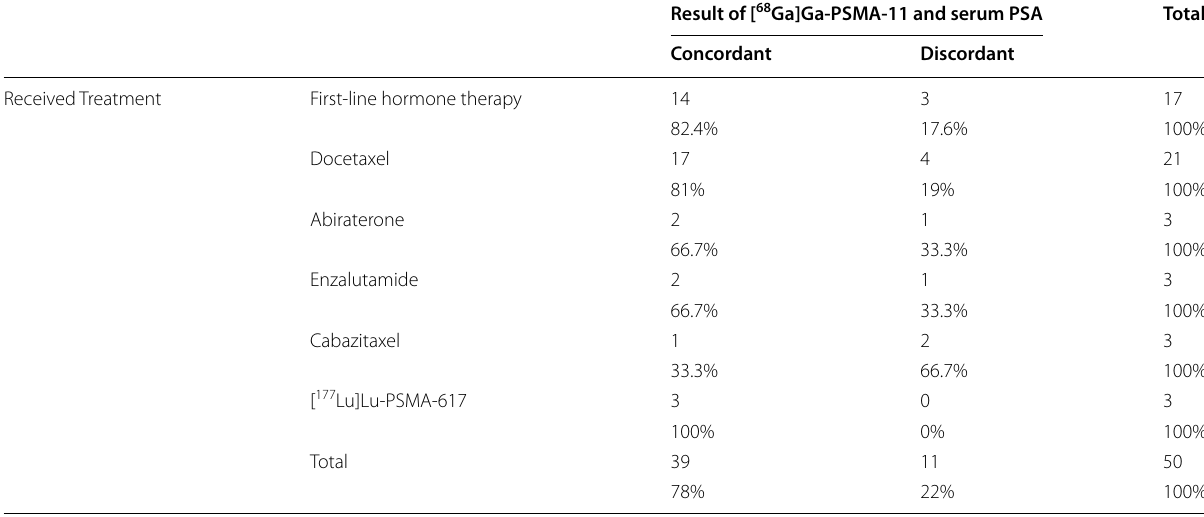
Table 4 The distrubution of received therapies in concordant and discordant results